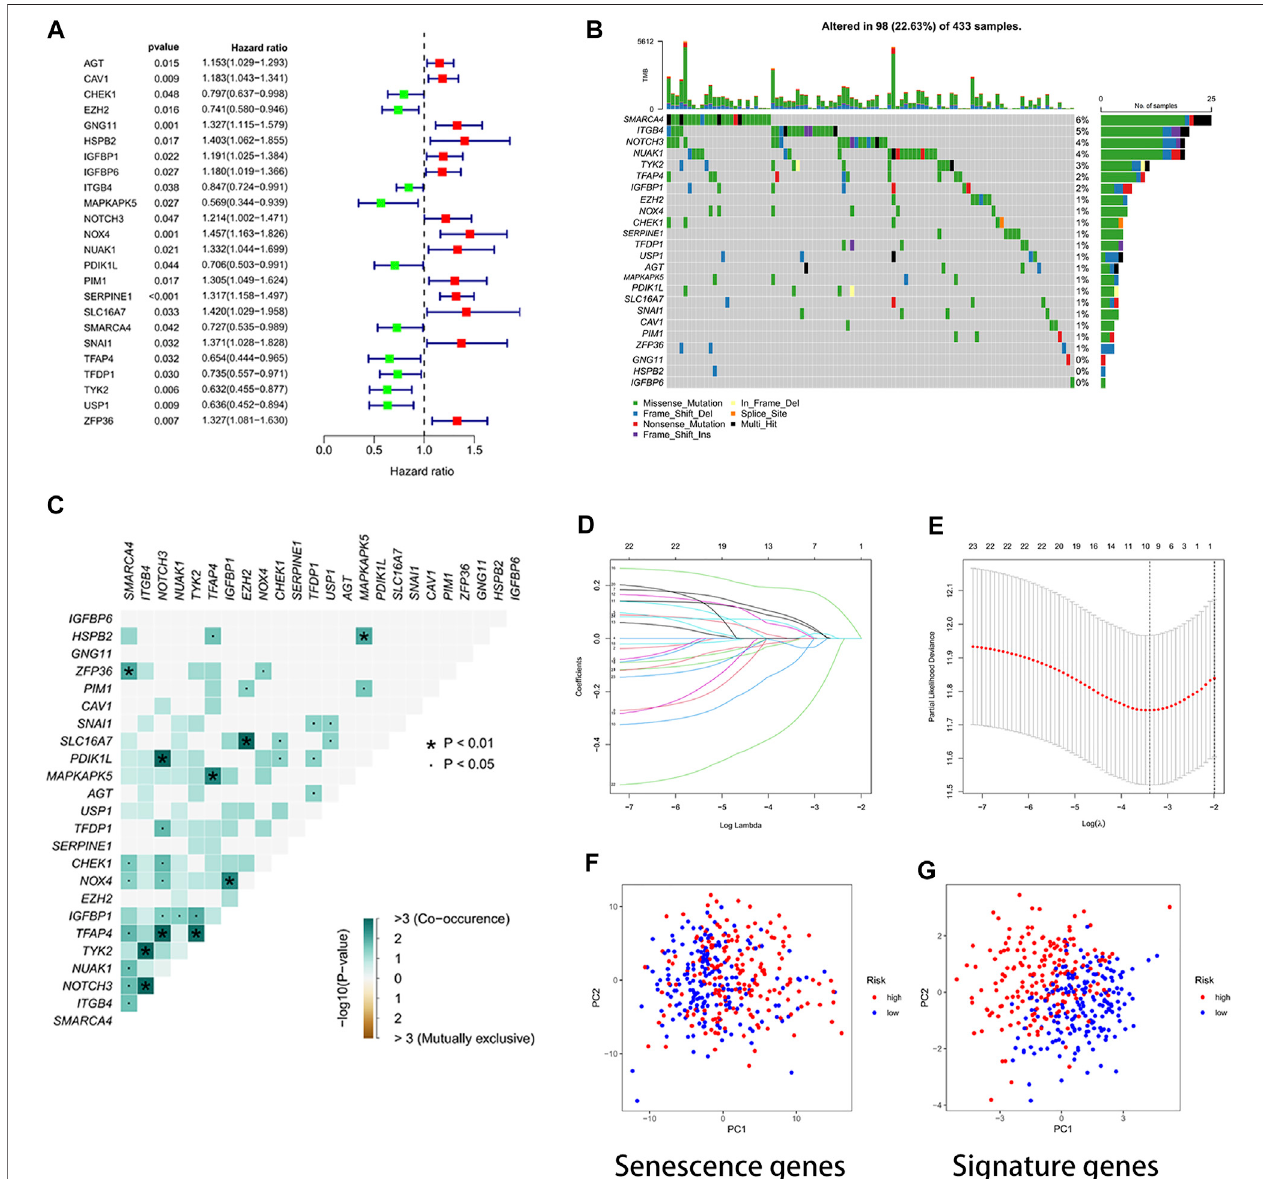
FIGURE 2 | Developing a prognostic signature. (A) Forest plot. The 24 cellular senescence-related genes associated with GC prognosis. (B) Waterfall plot. Mutation frequency of 24 cellular senescence-associated genes. A total of 98 sample mutations have occurred in 433 gastric cancer samples. (C) Mutation co- occurrenceandexclusionanalysis.Green,co-occurrence;purple,exclusion. (D) LASSOregressioncoef fi cients. (E) Identi fi edgeneswereusedtoconstructasignature. (F) PCA diagram. The high- and low-risk groups were distinguished by cellular senescence-associated genes. Groups marked in blue represent low-risk patients, and groups marked in red represent high-risk patients. (G) PCA plot. The risk score signature genes distinguished high- and low-risk groups of patients with high accuracy.